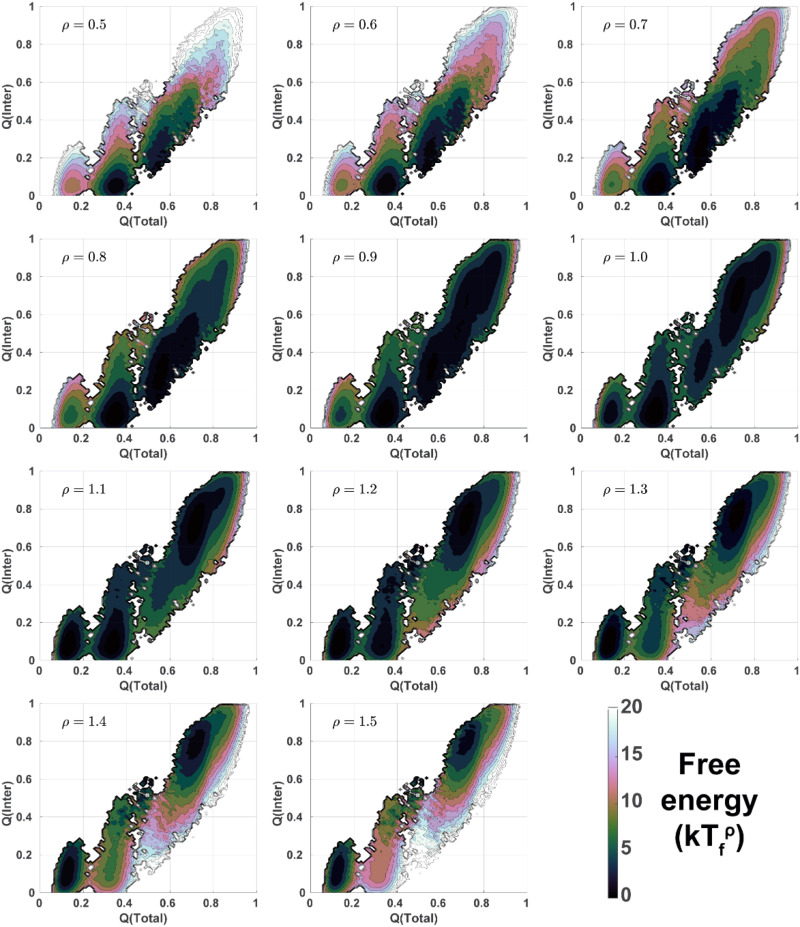
2D free energy landscapes for DPO4 folding with different values of ρ.2D folding free energy landscapes of DPO4 for different values of ρ at the corresponding folding temperatures Tfρ.